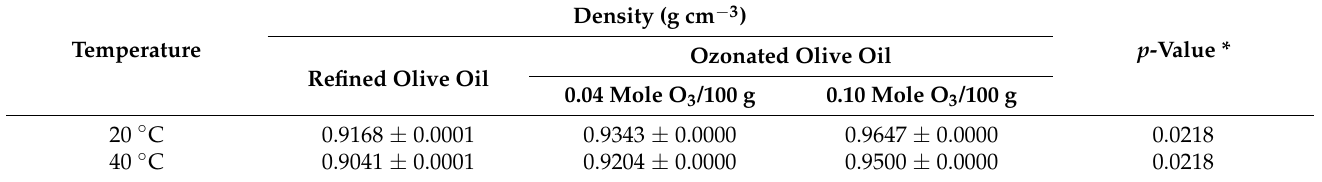
Table 3. The effect of temperature on the density of olive